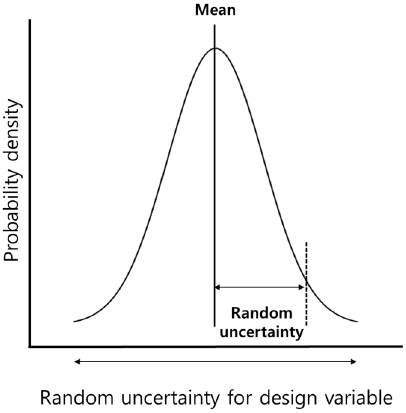
Figure 3. Random uncertainty in design variables.